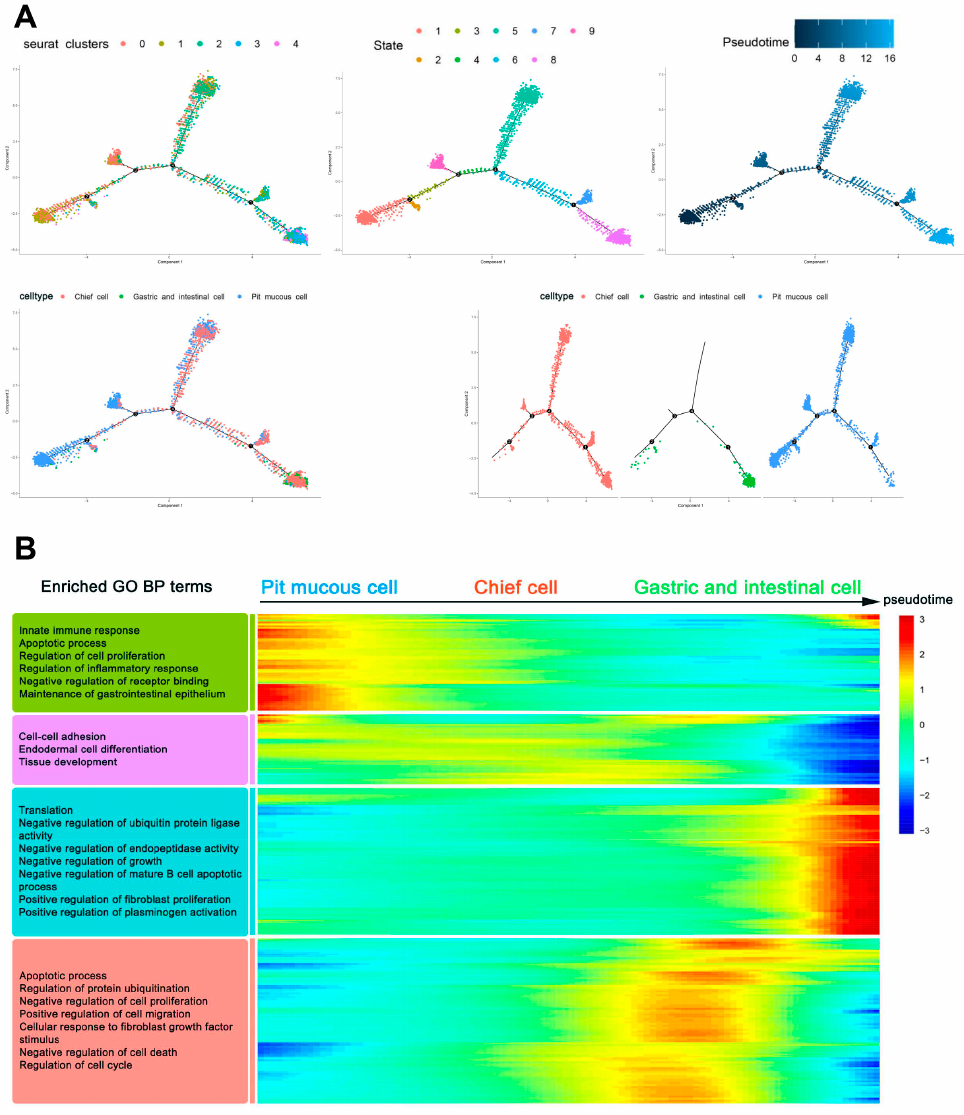
Figure 7. Trajectory analysis of malignant epithelial cells. ( A ) Trajectory plots showing the differenti- ation of the three subtypes. ( B ) Heatmap showing the scaled expression of dynamic genes along the pseudotime. Rows of the heatmap represent genes that show dynamic changes along the pseudotime, and these genes were clustered into four groups according to their expression pattern along the pseudotime. The annotated GO:BP terms in each cluster were